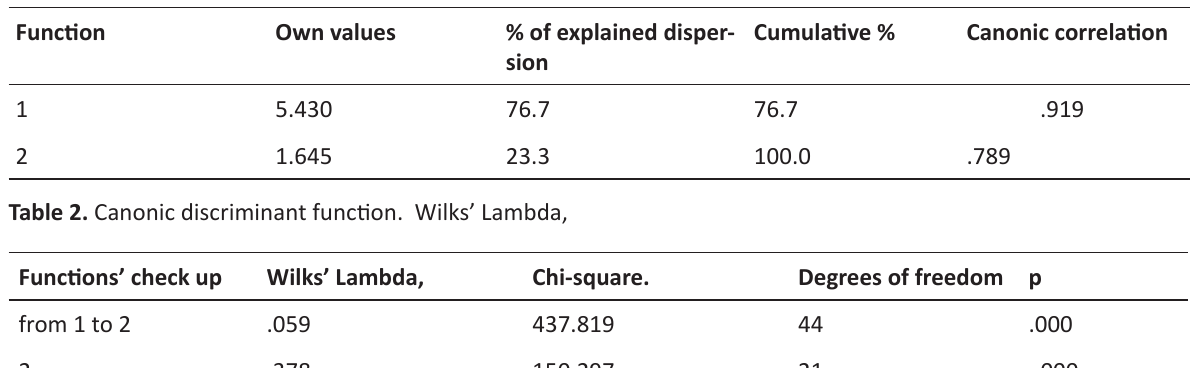
Table 1. Canonic discriminant function. Own values Function